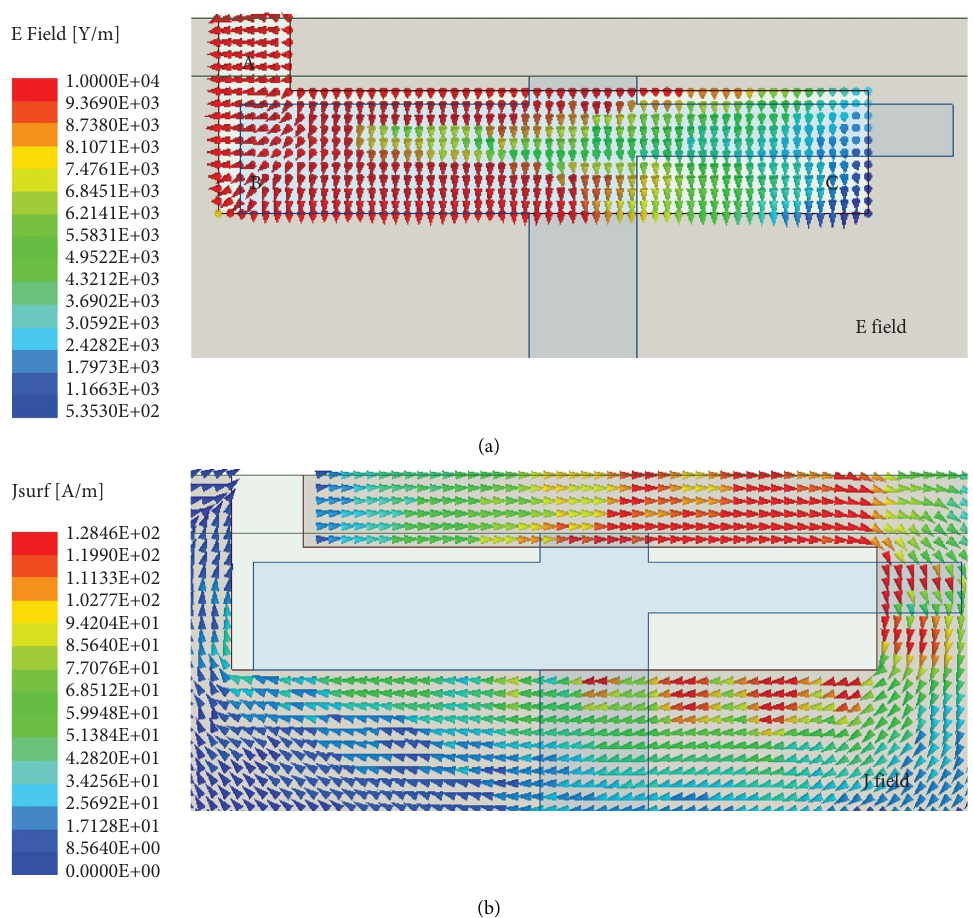
Figure 4: (a) Te electric feld intensity and (b) the current distribution of the open slot at 4.5